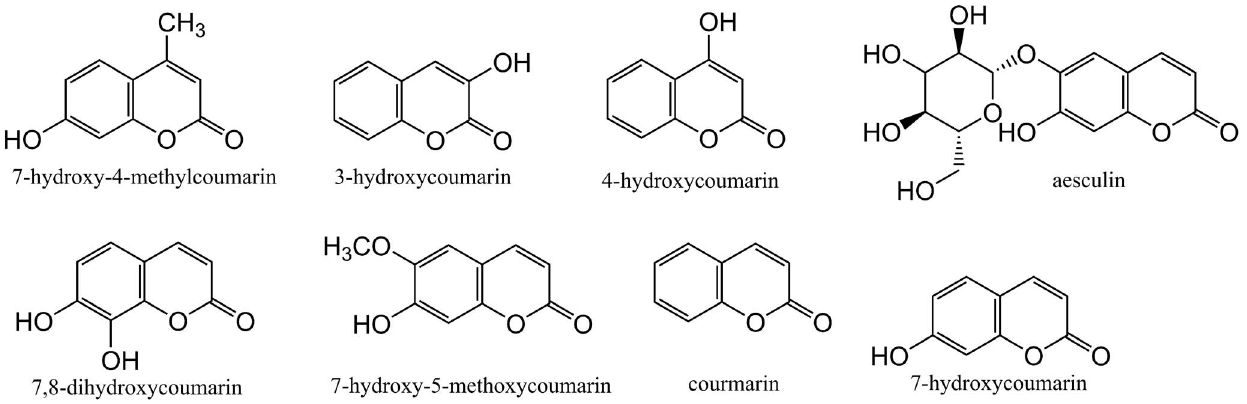
Figure 7. Coumarins in the 139-compound polyketide-based library. doi:10.1371/journal.pone.0103598.g007 PLOS ONE |